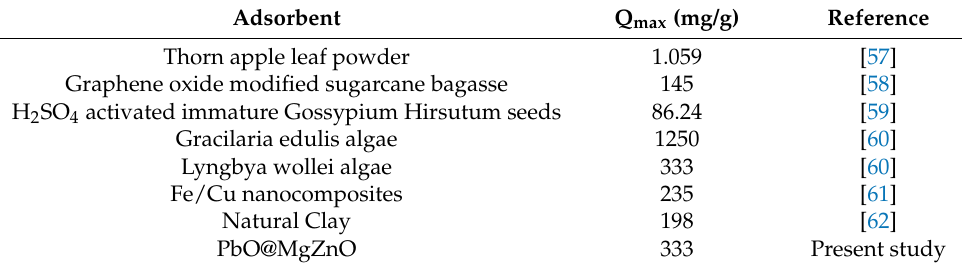
Table 5. Comparison of adsorption capacity of PbO@MgZnO with other adsorbents.